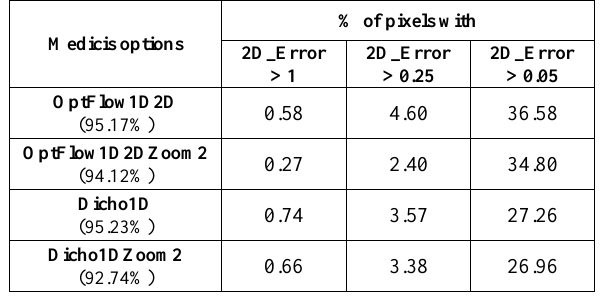
Table 2: Percentage of pixels with 2D_Error > 1, 0.25 or 0.05 pixel obtained on Bergerie1 with several Medicis options that are defined in Table 1. The percentage between brackets in column 1 corresponds to the density of the Medicis output grid obtained (percentage of valid